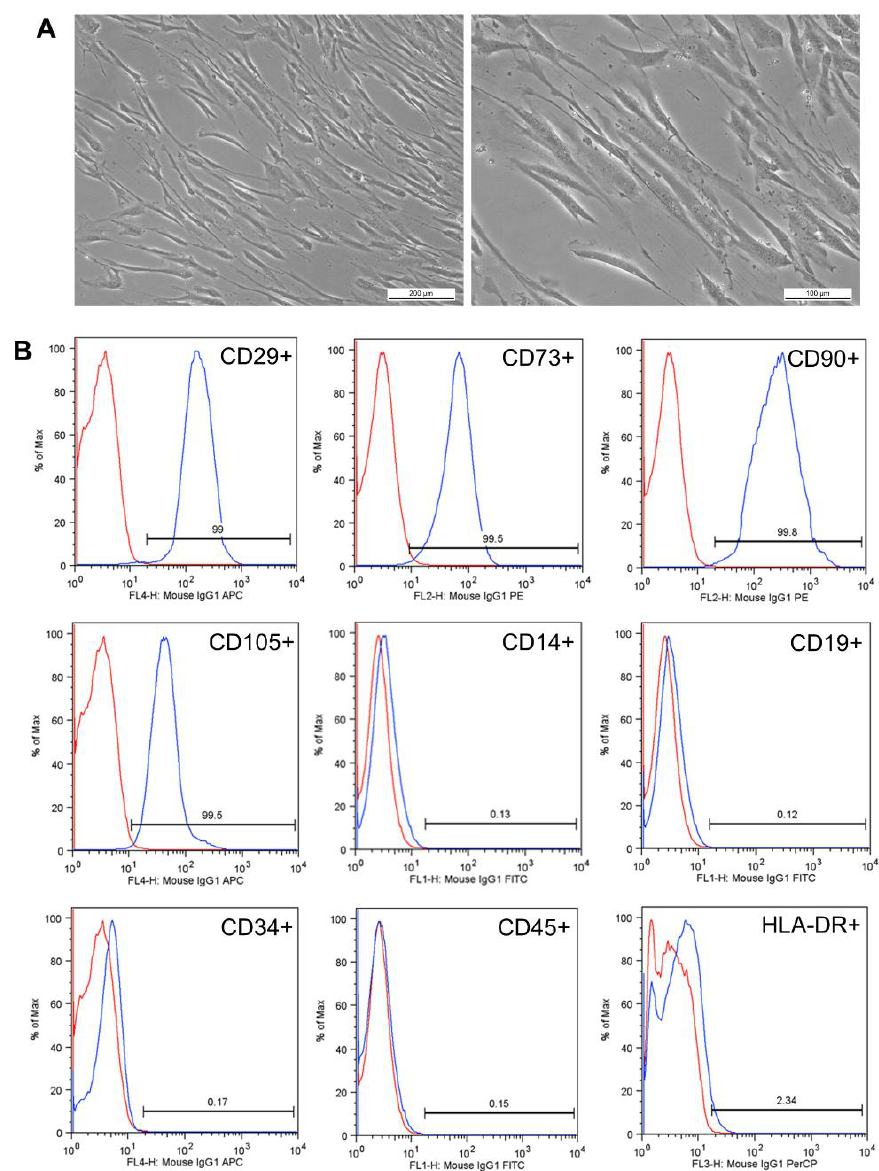
Figure 4. Characterization of hDPSCs. ( A ) Representation of a sample in the third passage. hDPSCs had plastic adherence and a fibroblastoid morphology. The images were magnified by 100× and 200×, respectively. ( B ) hDPSC surface markers of a study sample. In red, the isotype control is shown, and in blue, the positive markers CD29, CD73, CD90, and CD105 and the negative markers CD14, CD19, CD34, CD45, and HLA-DR are represented. The results are expressed as a percentage (%).